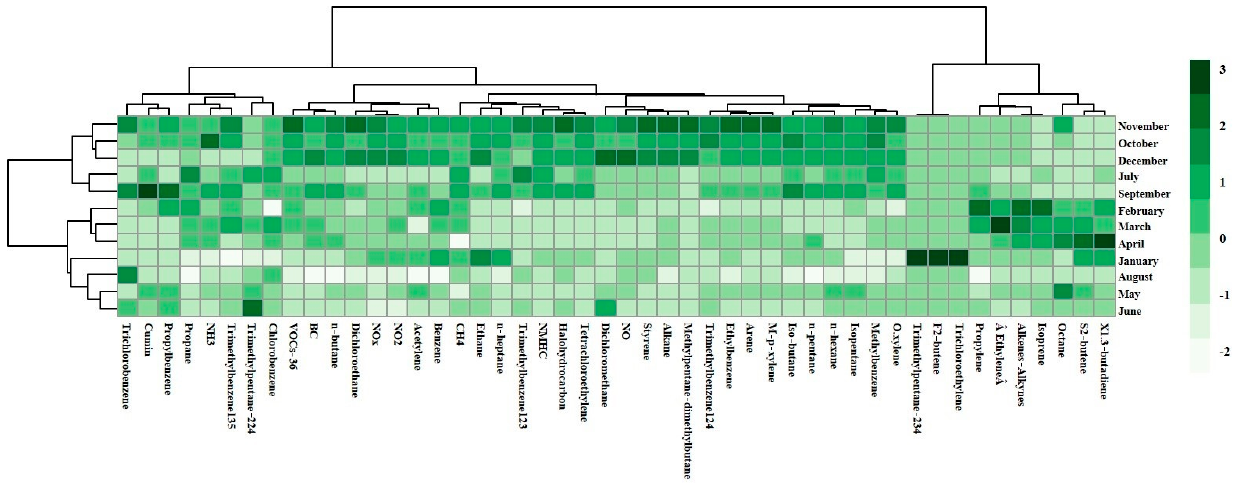
Figure 4. The results of analysis of BC concentration in 2018. ( Note: The color of the square lattice in the heatmap represents the concentrations of BC. Darker indicates worse pollution).